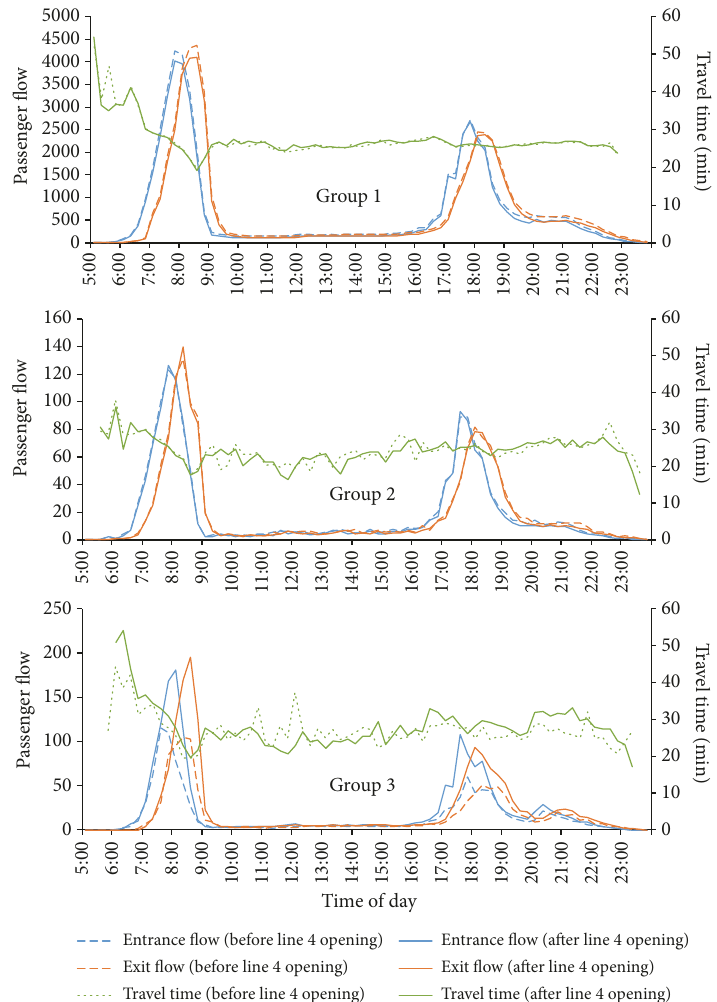
Figure 8: 15 min flow distributions of different groups of commuters and their travel times before and after Line 4 opening.